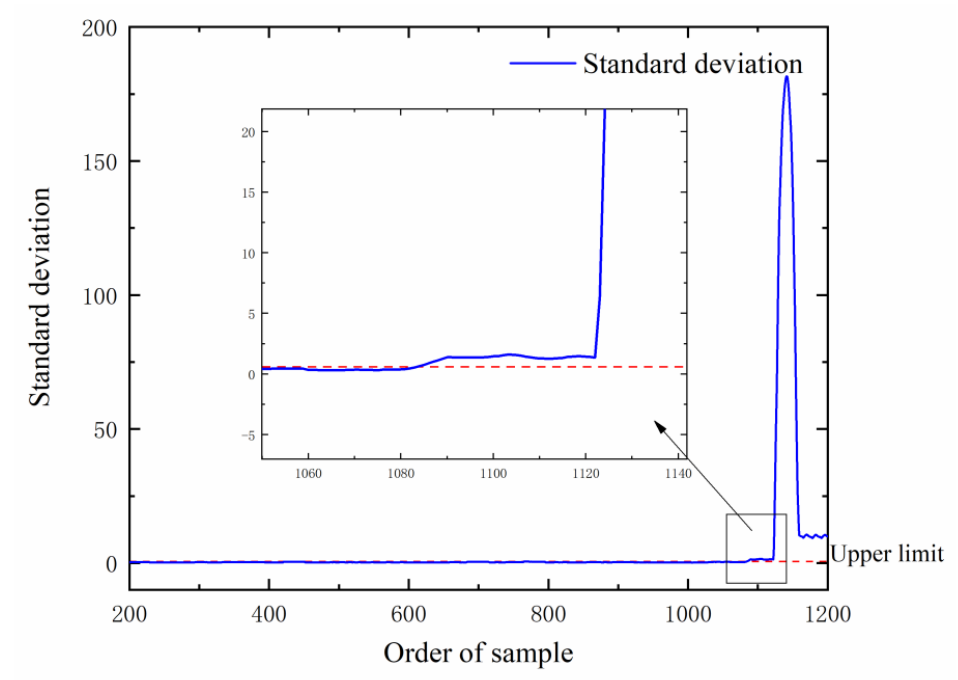
Figure 16. Standard deviation curve of abnormal state.